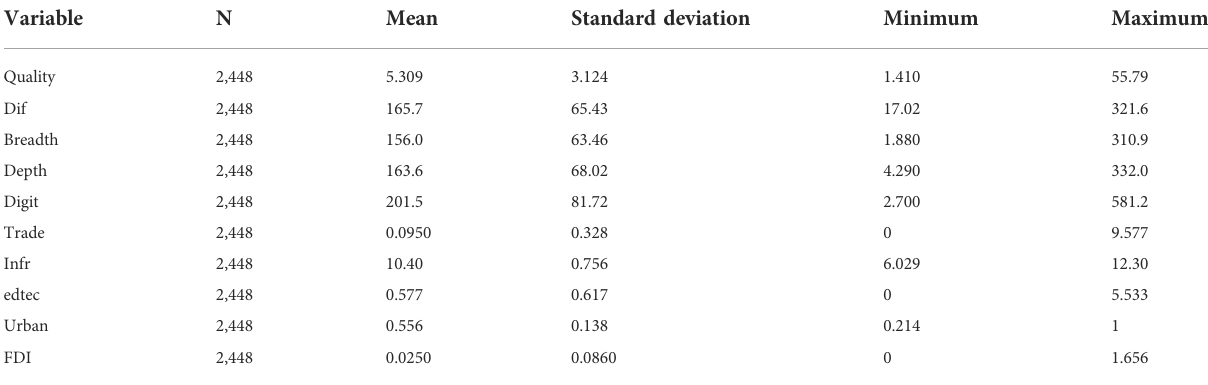
TABLE 1 Summary of descriptive